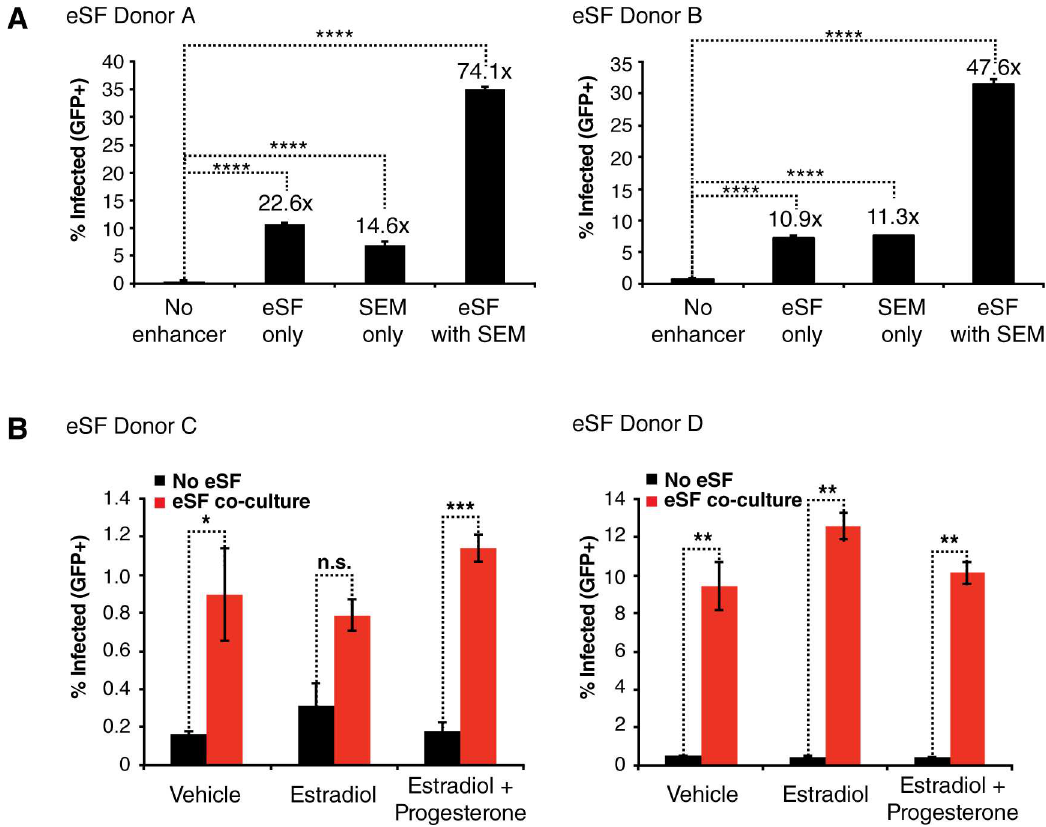
Fig 4. eSF enhance HIV infection of CD4+ T cells in the presenceof semen fibrils and ovarian steroids. (A) Activated PBMCs were infected with BaL GFP in the presence of eSF from two donors, in the presence of SEM fibrils, or in the presence of the two in combination. Infection levels were monitored3 d later by flow cytometry. Numbers abovebars correspond to fold-enhancement relativeto infectionlevels in the absenceof both eSF and SEM fibrils. **** p < 0.0001 relativeto No enhancer control in a group-wise comparison(one-wayanalysisof variancewith a Bonferroni posttest). Similar results were observed with X4-tropic HIV-1. (B) eSF from two donors were treated for 10–14 d with vehicle, estradiol alone, or estradioland progesterone in order to induce eSF decidualization. Proper decidualization of cells treated with estradiol and progesteronewas confirmedby IGFBP-1 ELISA (IGFBP1 levels > 500 ng/100,000cells in 0.5 ml culture). PHA/IL2-activated PBMCs incubatedwith or without vehicle-or hormone-treated eSF were infected with BaL GFP and monitored3 d later for infectionlevels by flow cytometry. Results are gated on live, singletCD3+CD8-cells. Results are representative of data from four eSF donors total. * p < 0.05, ** p < 0.01, *** p < 0.001, n.s. = non-significant (2-tailed t test). Similar results were observedwith X4-tropic